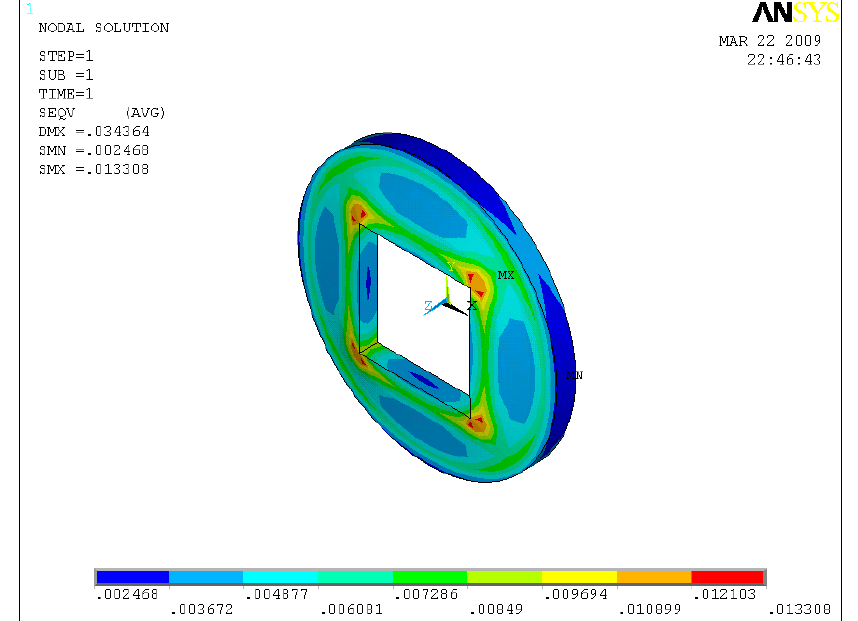
Figure 5. PDMS membrane stress distribution under the magnetic